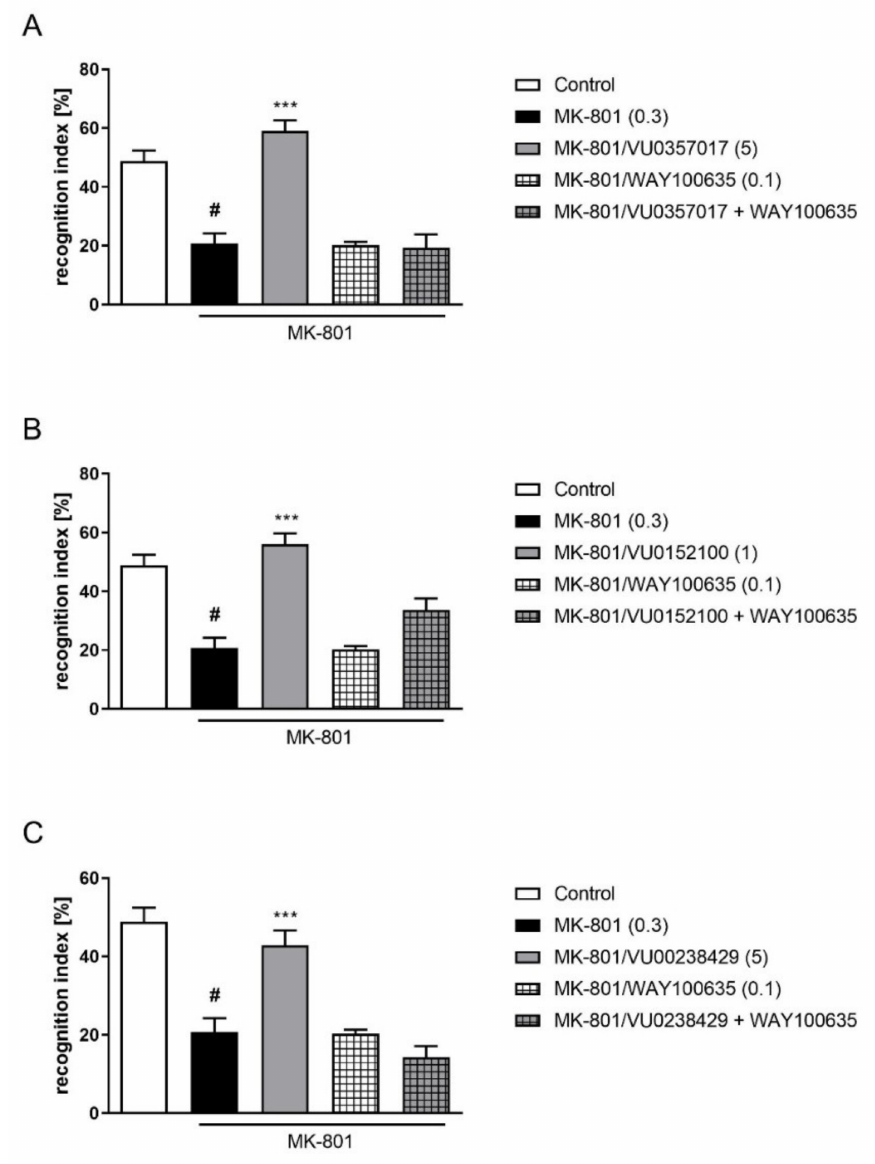
Figure 5. Activity of the combined administration of WAY100635 with active dose of VU0357017 ( A ), VU0152100 ( B ), or VU0238429 ( C ) in the NOR test. The data are presented as means ± SEM. Doses of the compounds are indicated in parentheses. # p < 0.001 compared to control animals and *** p < 0.001 compared to MK-801-treated